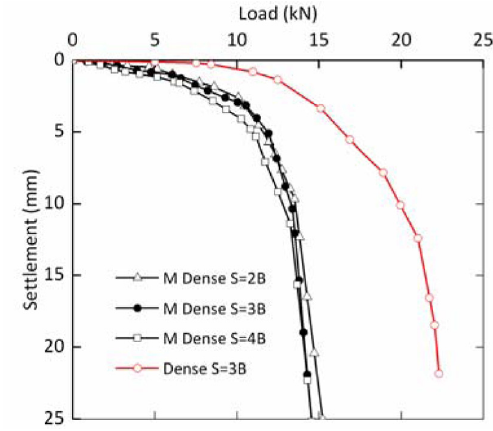
Fig. 7. Comparison of 4-pile group tests for medium dense sand vs.